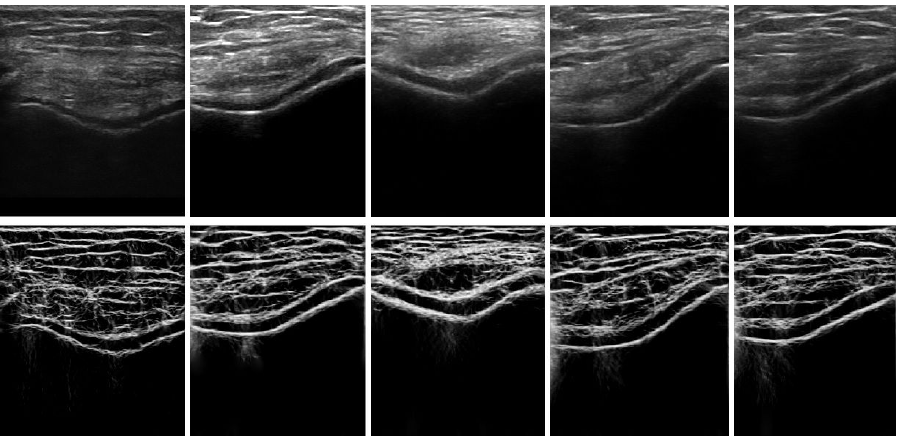
Figure 2. In vivo ultrasound (US) image enhancement: Top row: In vivo B-mode knee-cartilage US image ( US ( x , y ) ). Bottom row: Enhanced knee-cartilage US image ( USE ( x , y )